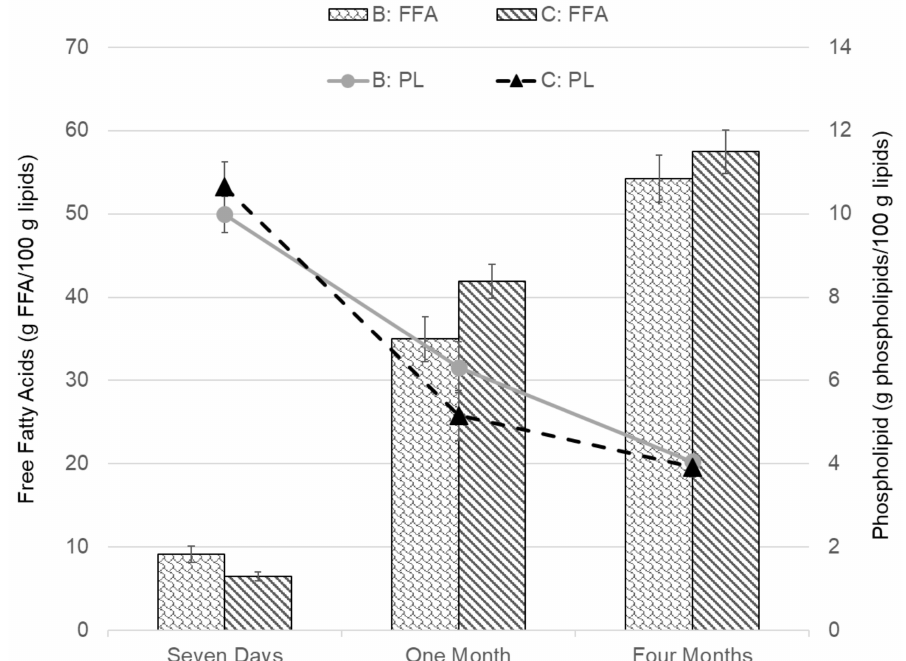
Figure 4. Comparison of Free Fatty Acids (FFA) and Phospholipids (PL) results for Groups B and C. The error bars show the standard error of the mean values ( µ ± σ µ ).